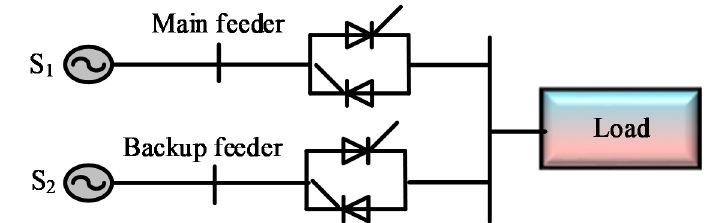
Figure 2. IEEE benchmark system STS-1 [11].